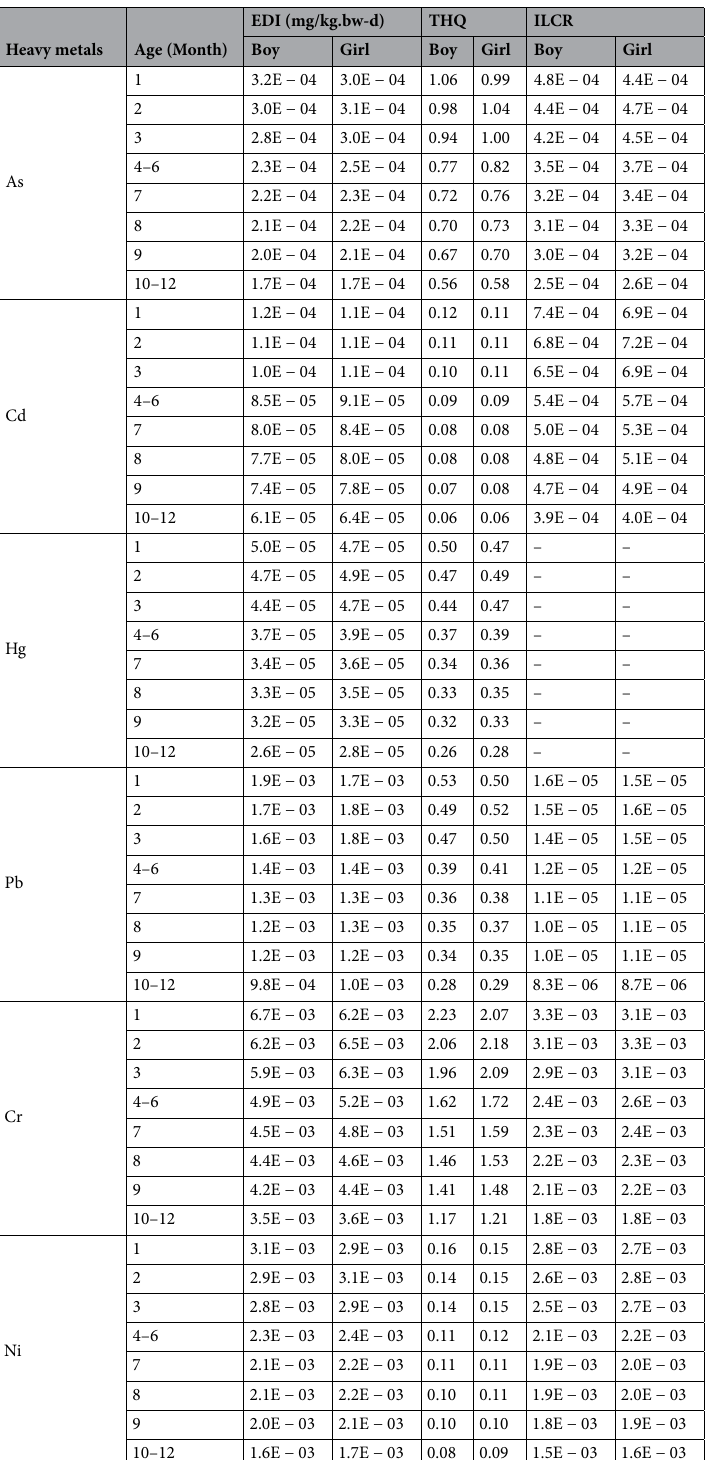
Table 2. The EDI, THQ, and ILCR related to toxic metals of breast milk for infants of different